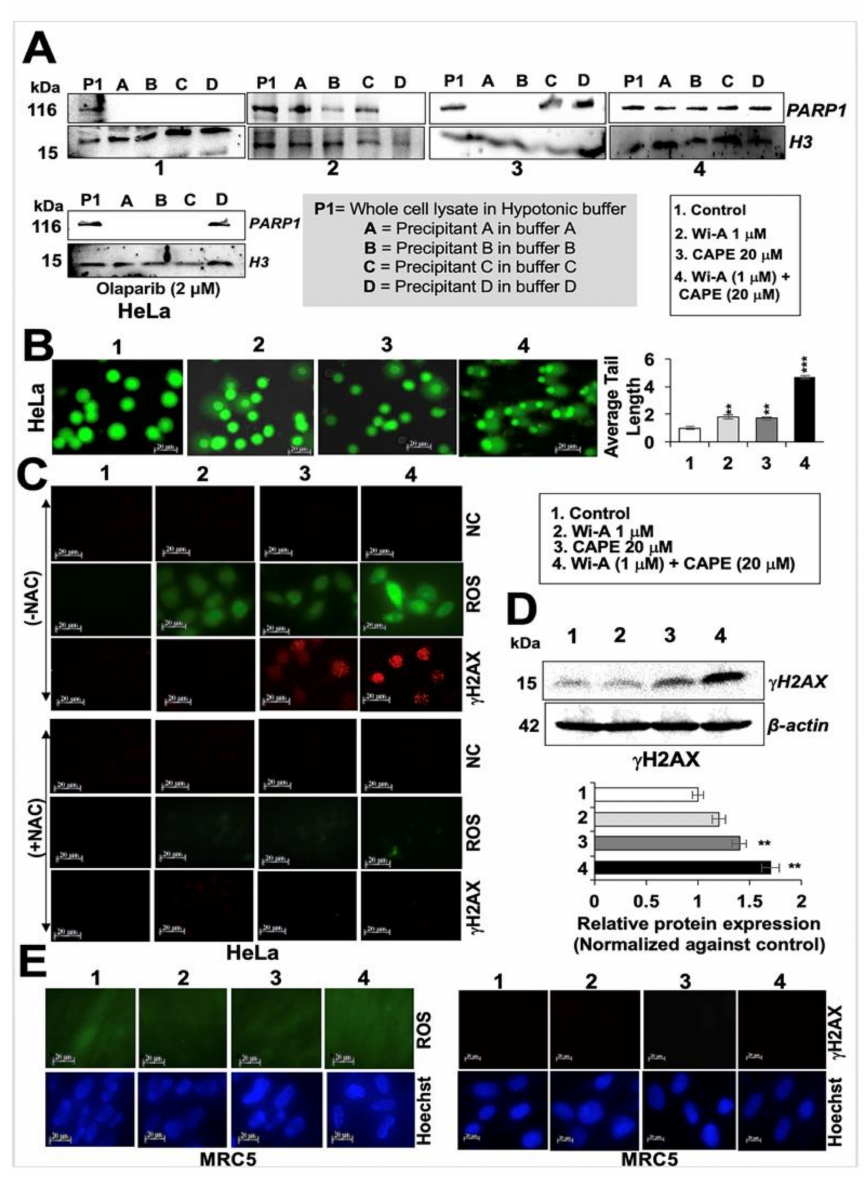
Figure 6. Withaferin A (Wi-A) and ca ff eic acid phenethyl ester (CAPE) directly interact with PARP1 and inhibit its function by DNA trapping. Western blot analysis of PARP1-DNA complexes showing trapping of PARP1 in DNA in Wi-A, CAPE, and their combination treated cells ( A ). Stronger trapping was observed in cells treated with the combination; Olaparib was used as a positive control. Alkaline comet assay showing accumulation of DNA damage in cells treated with Wi-A, CAPE and their combination ( B ); Scale bar–20 µ M; the latter showed a remarkable increase. Immunostaining of H2A histone family member X ( γ H2AX) in control or in treated cells with either Wi-A or CAPE or their combination showing sharp increase in the number of γ H2AX foci in the latter ( C - above ); cells pretreated with NAC showed abrogation in induction of ROS and γ H2AX ( C - below ). Negative control (NC- above ) shows staining with first antibody only; Scale bar–20 µ M. Western blot showing increase in γ H2AX in Wi-A, CAPE, and their combination treated cells ( D ). Immunostaining of normal cells treated with Wi-A, CAPE, and their combination is shown ( E ); Scale bar–20 µ M. Data were normalized against the control and plotted as fold di ff erence. Each data set represents the mean ± SD for at least three independent biological replicates. Statistical significance was defined as p -values where ** < 0.01 and *** < 0.001 represent very significant and highly significant,